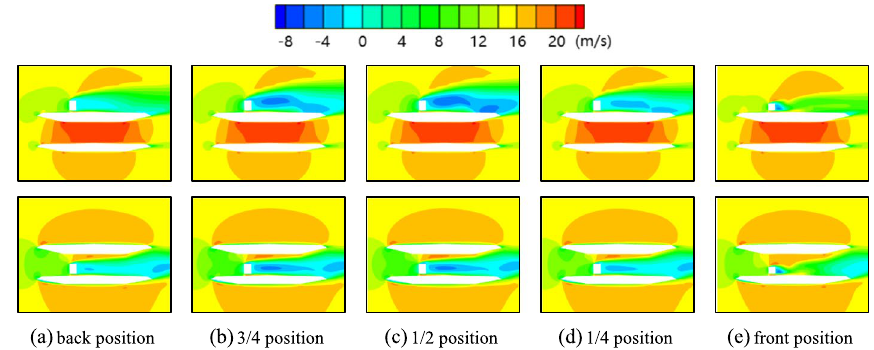
Fig. 18 Counters of the mean velocity for different cross sections (vehicle on lane 2)